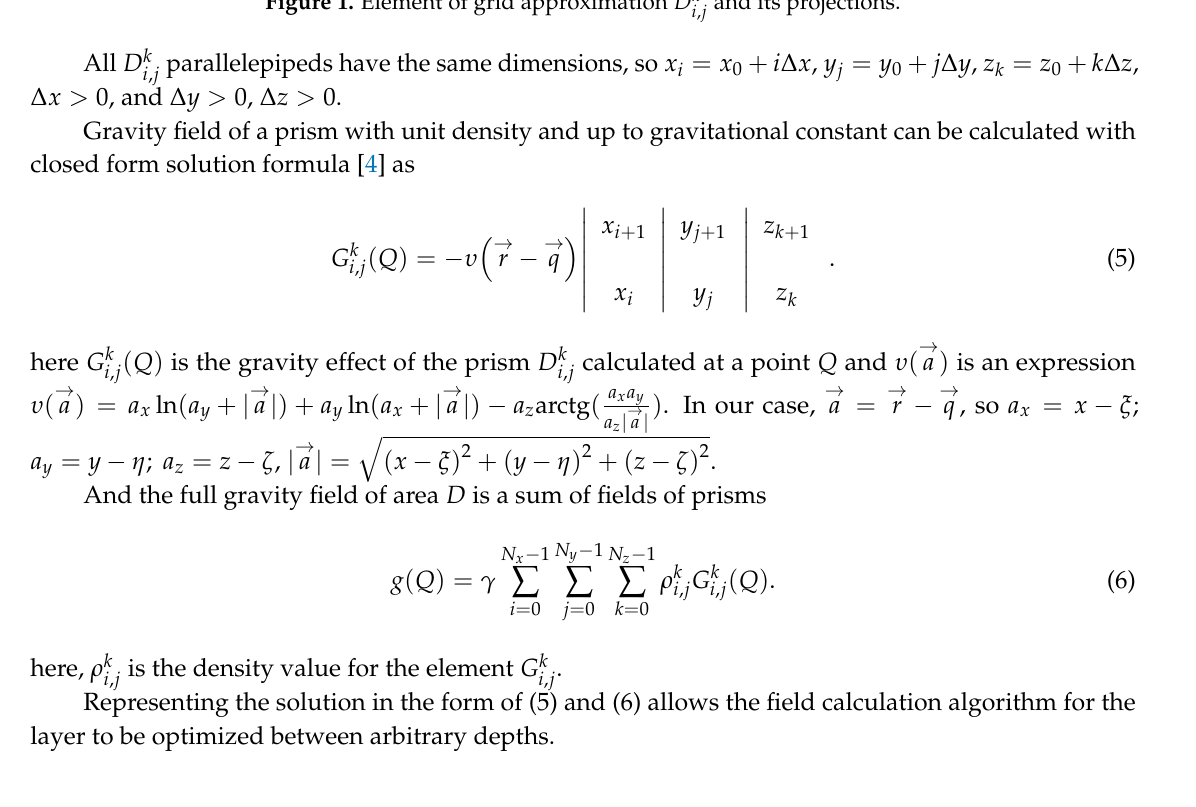
Figure 1. Element of grid approximation 𝐷 (cid:3036),(cid:3037)(cid:3038) and its projections.